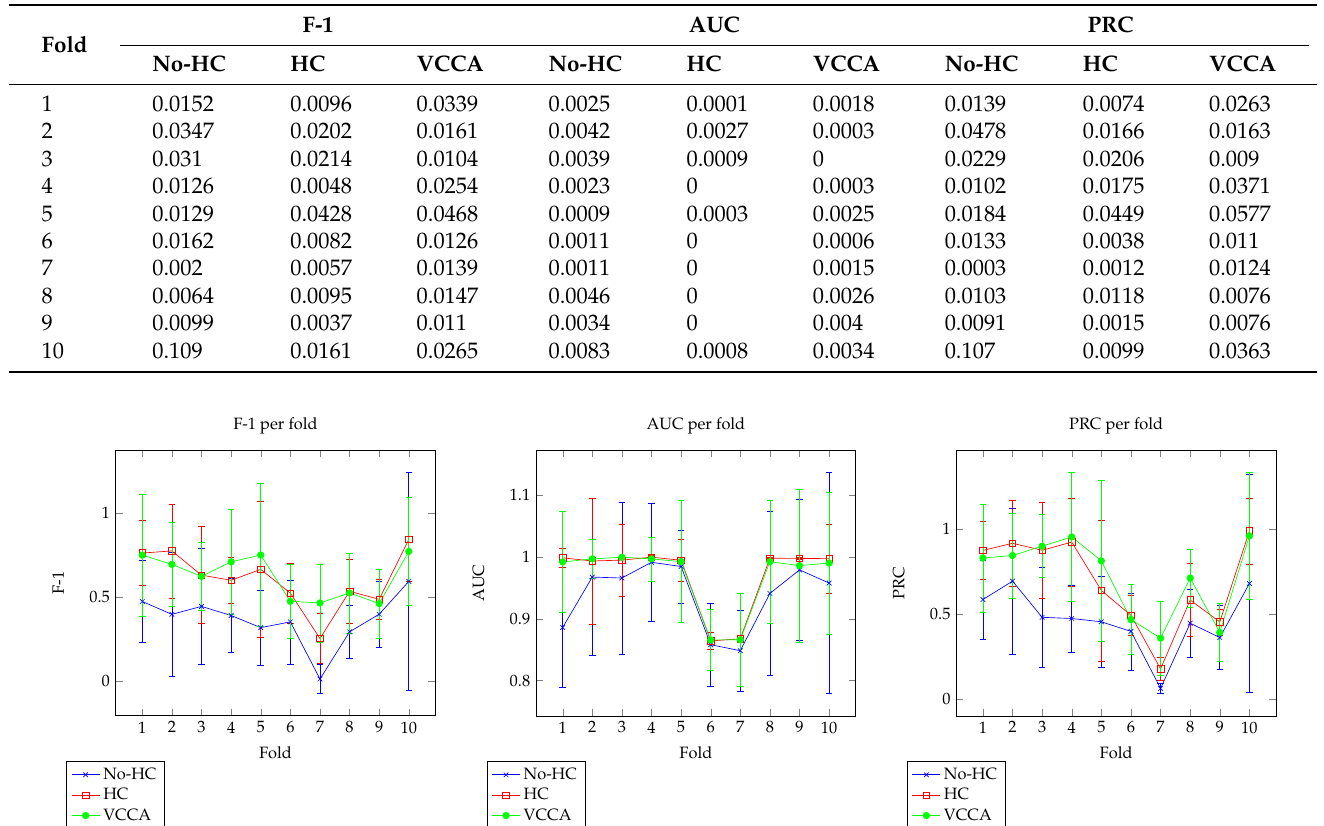
Table 6. The Variance of Metrics for Dataset 1.